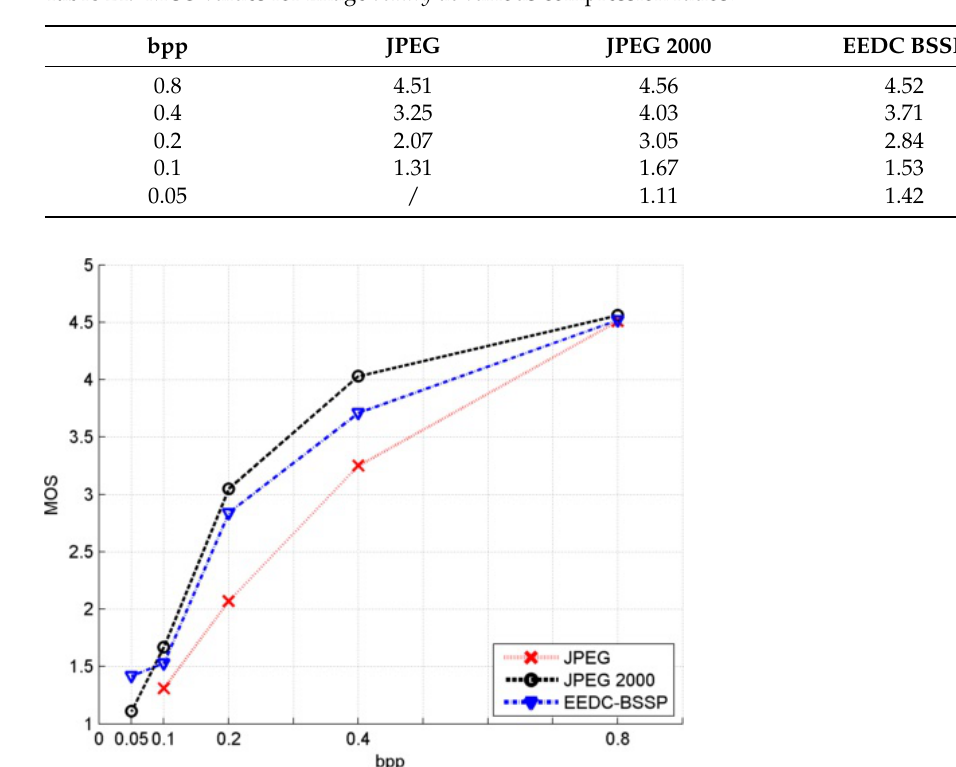
Table 24. MOS values for image beauty at various compression ratios.